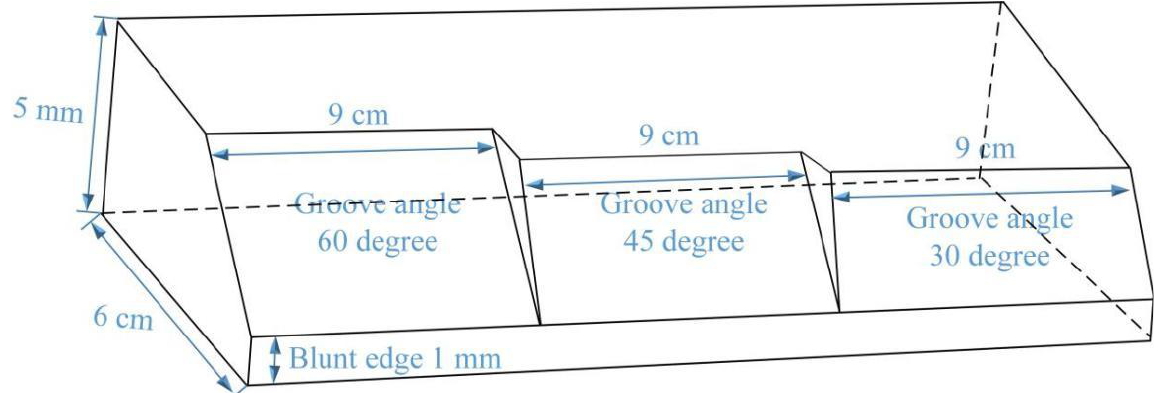
Figure 2. Structural diagram of a variable groove weldment.